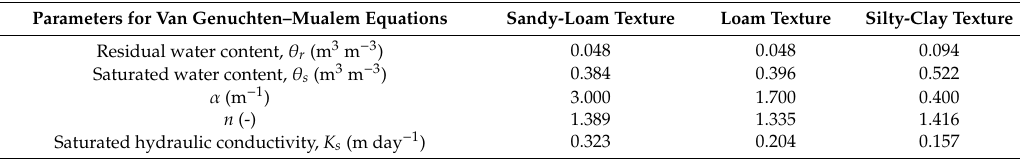
Table 2. Parameters of van Genuchten–Mualem equation used in the simulations. Parameters for Van Genuchten–Mualem